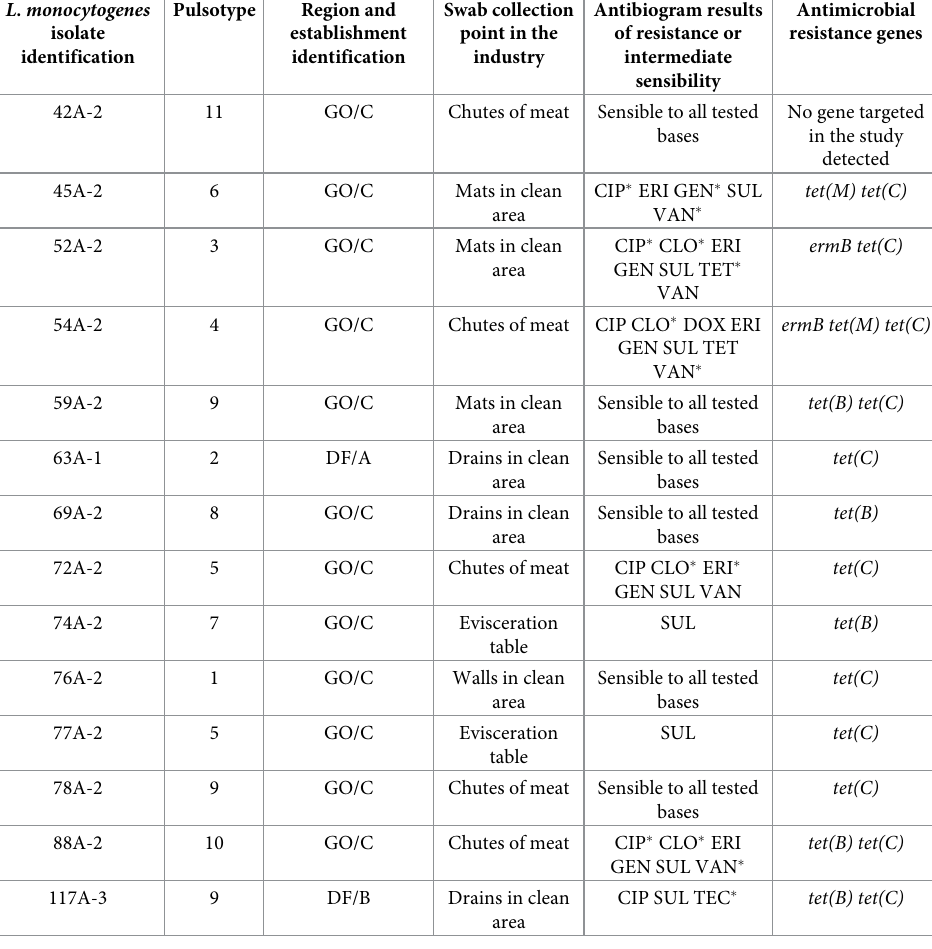
Table 4. Results of antibiogram susceptibility test and antimicrobial resistance genes for the 14 L . monocytogenes